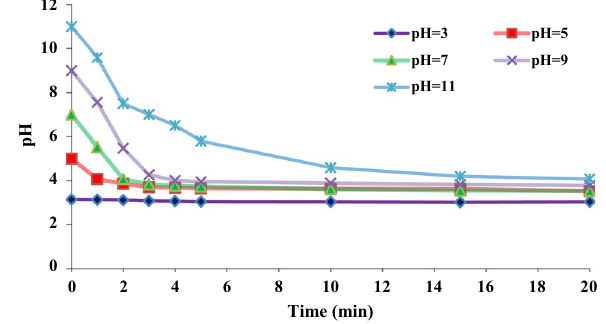
Fig. 4 The effect of pH with time on the removal efficiency of OTC (OTC conc. = 50 mg/l, ozone generation rate = 1.38 mg/s, reaction time = 35 min, at room temp.)